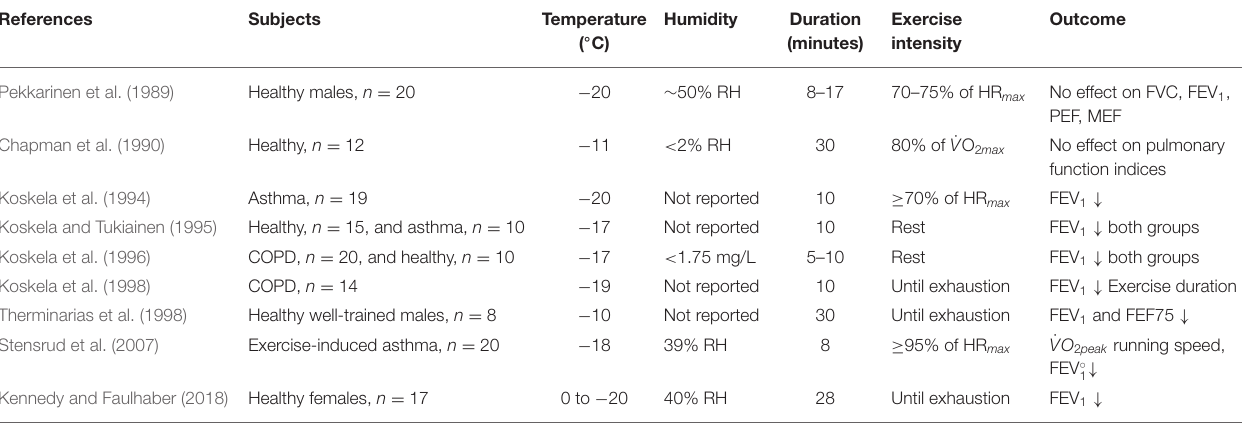
TABLE 1 | Experimental studies that have employed environmental chamber models to examine acute effects of short-term, whole-body exposure to sub-zero temperatures on lung function and other physiological